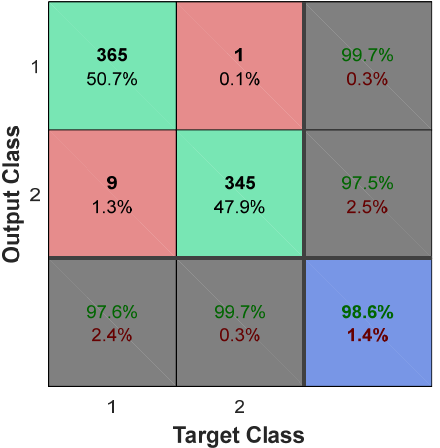
Figure 9. The confusion matrix of the proposed method as a result of brain tumor diagnosis in BRATS2014 database.